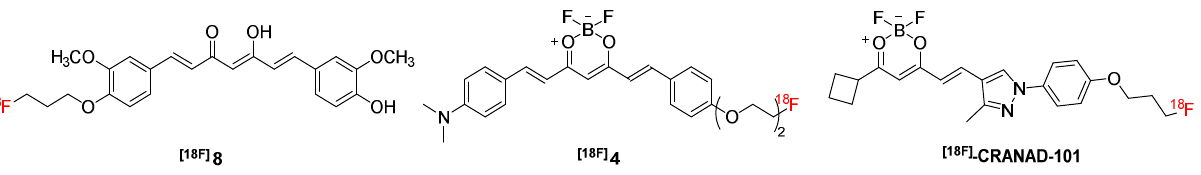
Figure 9. The chemical structures of different PET tracers.